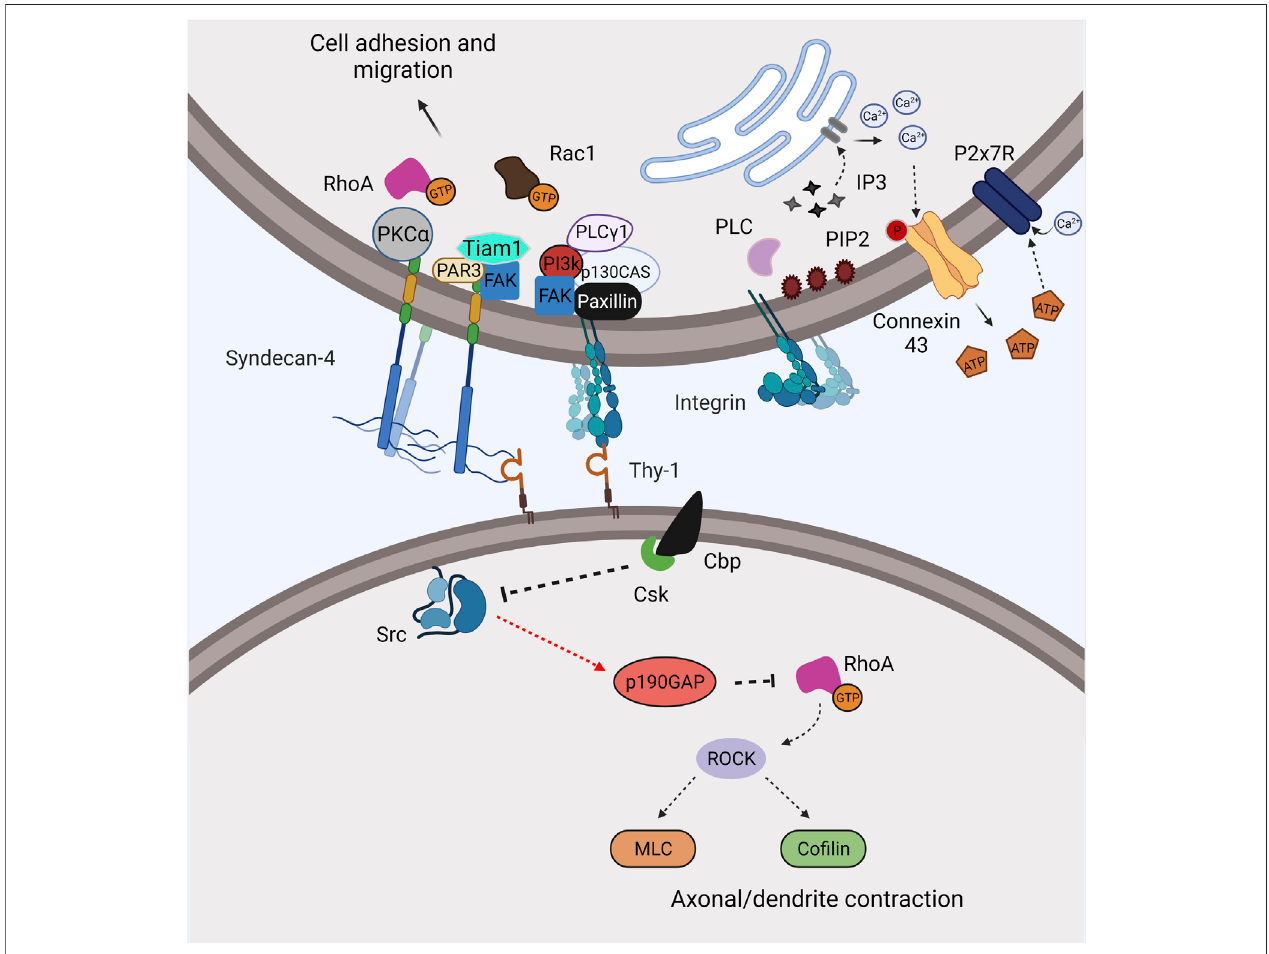
FIGURE1| Thy-1 mediatesand regulates integrinsignaling through trans -interaction with integrins. Thy-1 candirectlybind integrins and syndecan-4and mediate distinctivesignalingpathwaysbetweenthetwointeractingcells.RecruitmentofCbpbyThy-1tothelipidraftreducesSrcactivityandpromotescontraction.Ontheother side, signaling induced by Thy-1 – integrin/syndecan-4 interaction promotes adhesion and migration through canonical integrin outside-in signaling. The interaction also leads to elevated cellular Ca 2+ , opening of Connexin-43/Pannexin-1 hemichannels and activation of the P2X7R, resulting in astrocyte cell adhesion and migration.